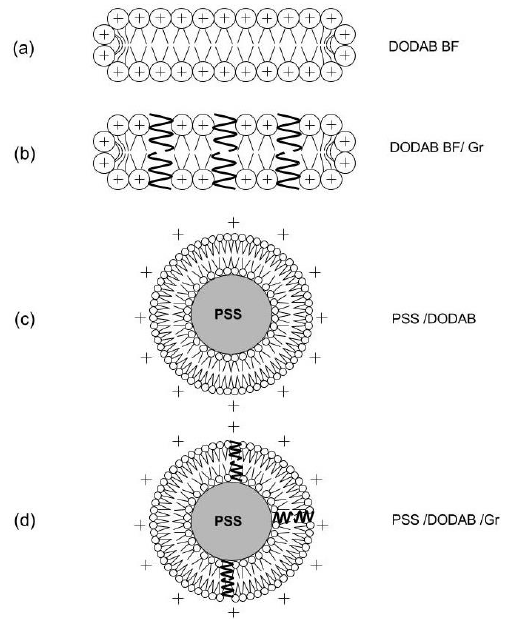
Figure 2. Procedure for obtaining the cationic biomimetic particles with two antimicrobials: DODAB and Gr dimeric channels. ( a ) Bilayer fragments (BF) of the cationic lipid DODAB [23,27]; ( b ) BF incorporating dimeric channels of Gr [24,25]; ( c ) PSS NPs covered by a DODAB bilayer [10]; and ( d ) PSS NPs covered by a DODAB bilayer with inserted Gr dimeric channels (this work). Schematic representations are